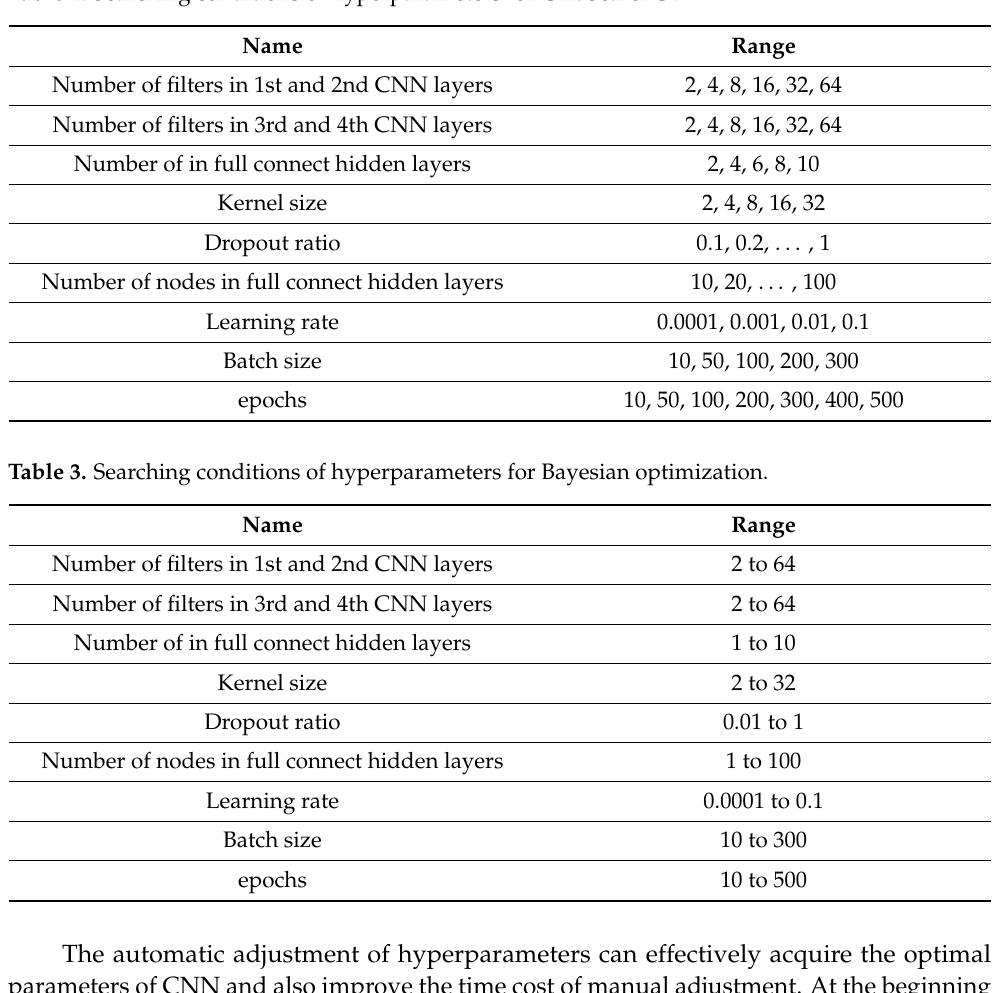
Table 2. Searching conditions of hyperparameters for GridSearchCV.